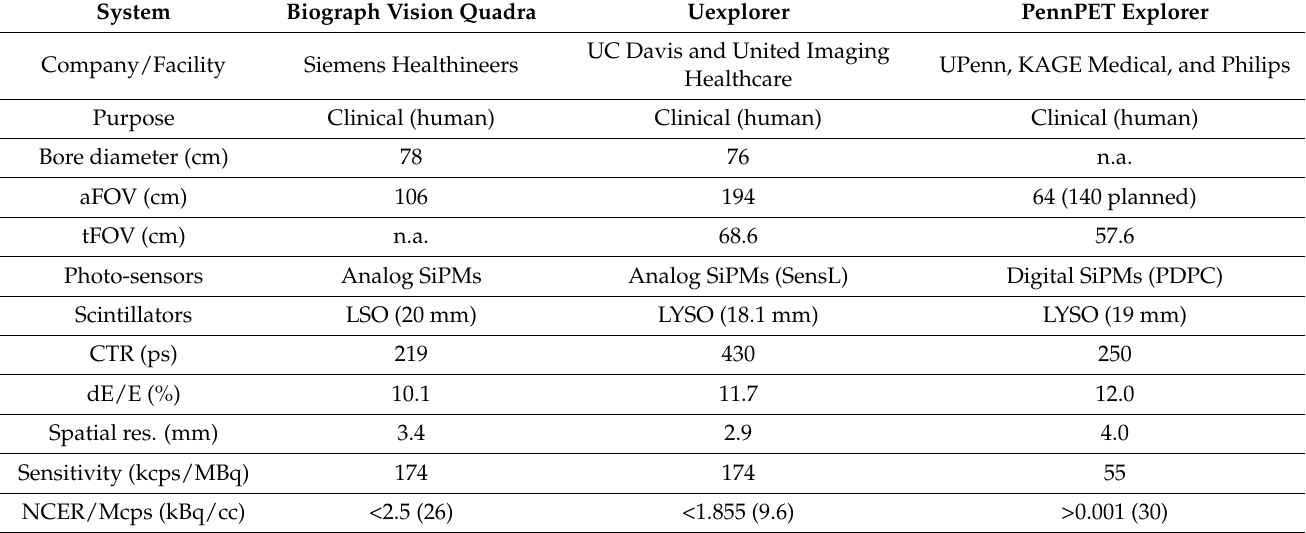
Table 1. Overview on existing TB PET/CT commercial systems. Table reproduced with permission from [1]. Copyright 2022 Springer Nature Switzerland